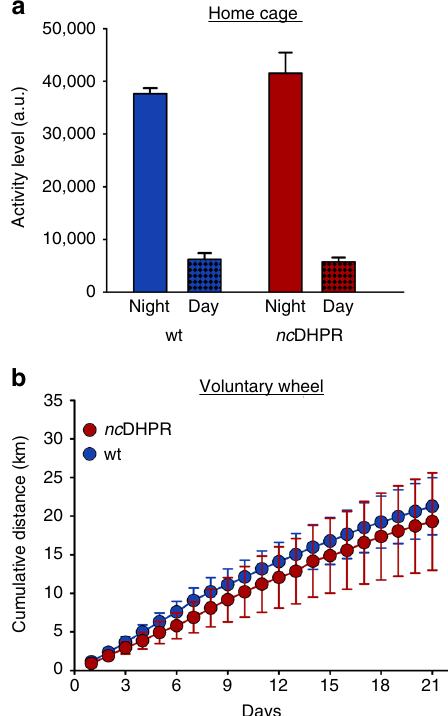
Fig. 5 Voluntary locomotor activity is identical in nc DHPR and wt mice. a Home cage ambulatory activity was measured for 2 days and 3 nights with an infrared video monitoring system. Young (3 – 6 months old) nc DHPR mice ( n = 10) displayed high nighttime activity (41,520 ± 3,934 a.u.) and low daytime activity (5,794 ± 790 a.u) similar ( P > 0.05) to the control wt mice (37,620 ± 1,079 a.u. and 6,247 ± 1,152 a.u., respectively; n = 6). b Average cumulative distance covered during 21 days of voluntary activity wheel task (binned every 24 h) was indistinguishable ( P > 0.05) between young nc DHPR ( n = 18) and wt ( n = 17) mice. Data are represented